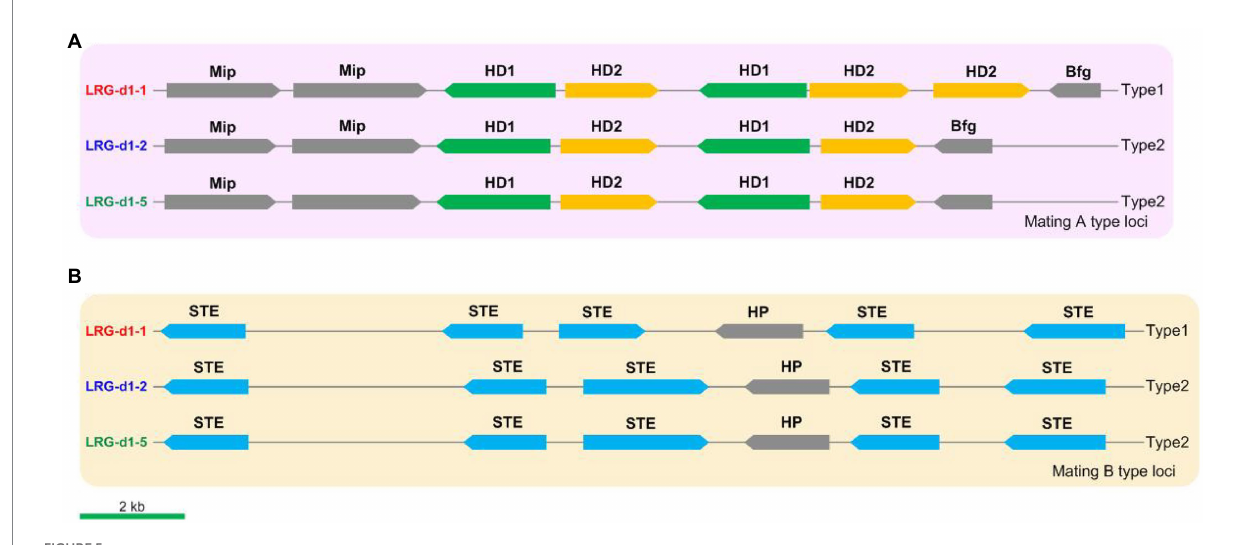
FIGURE 5 The structures and types of mating loci in Lyophyllum decastes . (A) The mating A structure of L. decastes . (B) The mating B locus of L. decastes